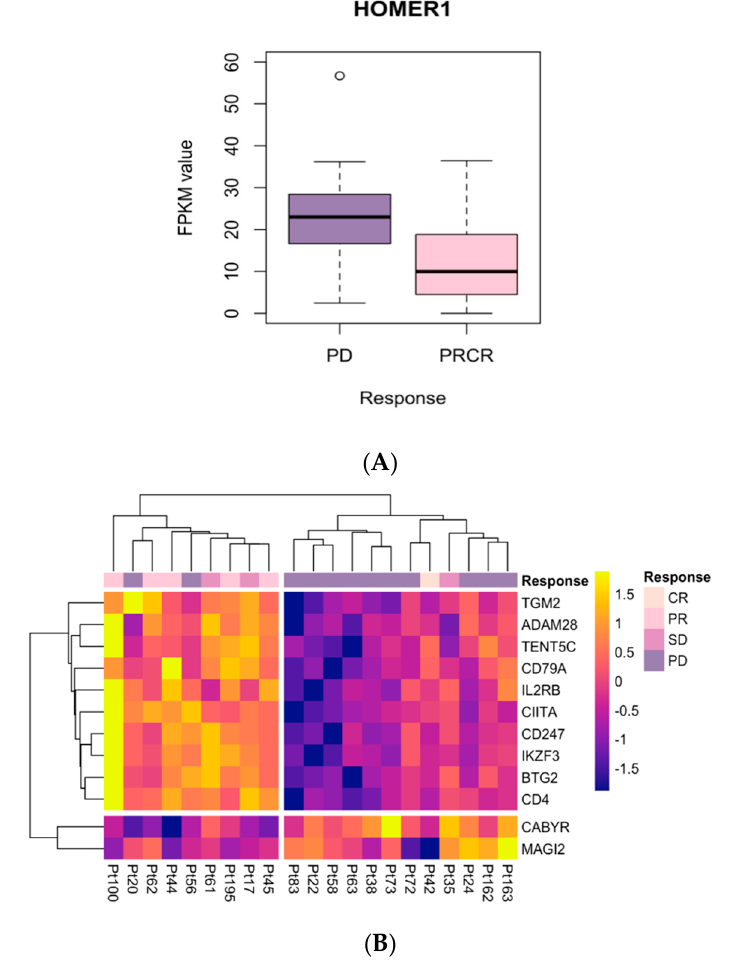
Figure 4. Candidate immune biomarkers from IMMUNETS are differentially expressed in independent datasets. ( A ): HOMER1 expression between responsive (PRCR, n = 15) and non-responding (PD, n = 14) groups in VALID_NAI. Significant expression differences were also observed in MEL_NAI, however the correlation with clinical response was not conserved, possibly arising from splice variation. ( B ) Twelve genes differentially expressed in VALID_PROG that were significant in MEL_PROG. The colour-coding for clinical response values is shown on the right-hand side. Heatmap colours represent Blom-transformed gene expression from yellow (highest) blue (lowest), values in the key represent a log scale.